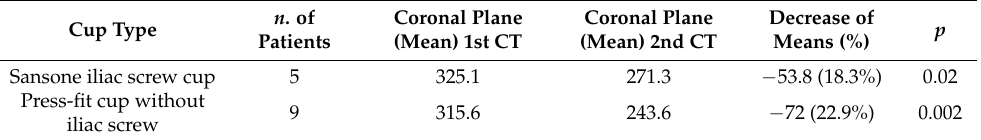
Table 11. Coronal plane changes comparing 5–10 weeks with 12-month follow-ups in identified